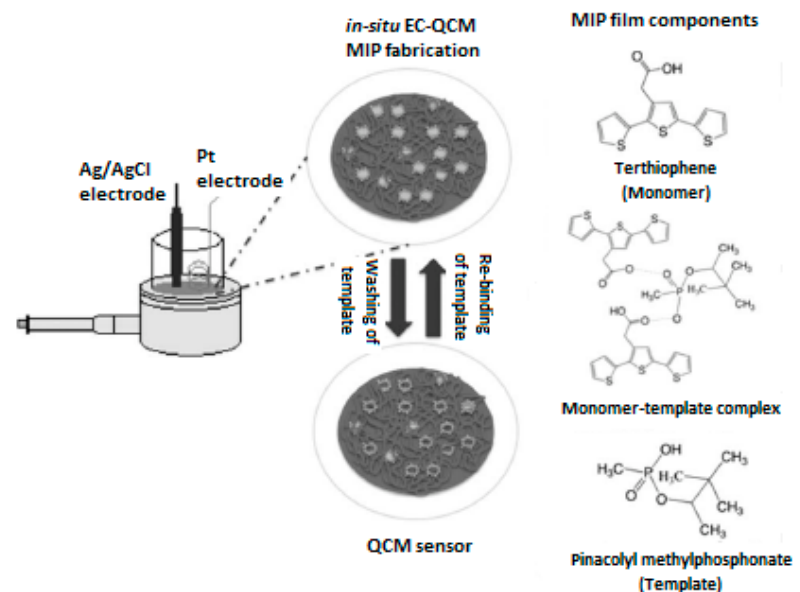
Figure 9. MIP-based QCM sensor toward pinacolyl methylphosphonate (reproduced with permission from [59]).